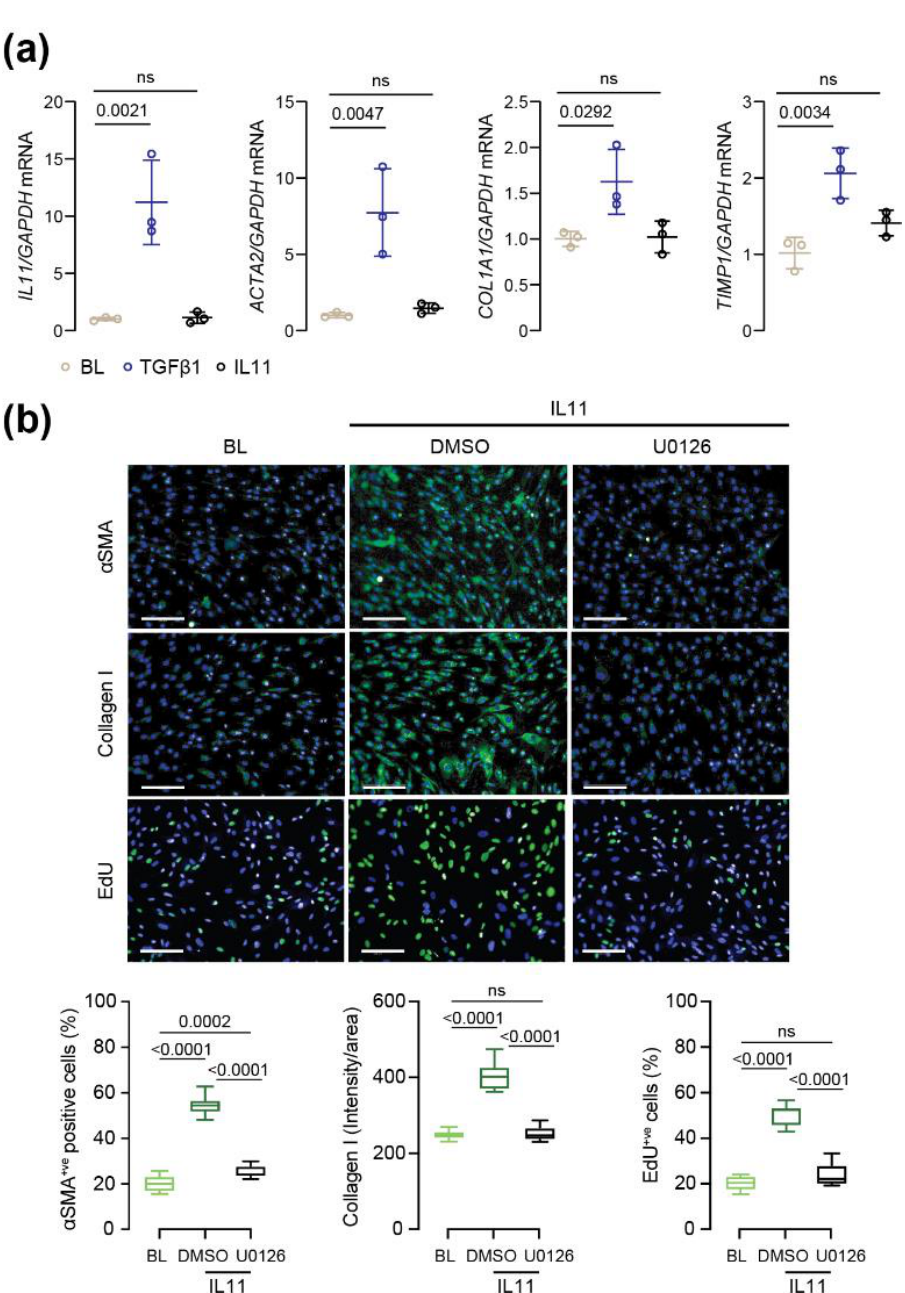
Figure 3. IL11 drives pancreatic stellate cell activation via ERK signalling and post-transcriptional effects. ( a ) RNA expression of IL11 , ACTA2 , COL1A1 and TIMP1 in PSCs treated with recombinant human TGF β 1 or IL11 (5 ng/mL; 24 h). ( b ) Representative immunofluorescence images and quan- tification of α SMA +ve cells, Collagen I intensity/area and EdU +ve cells at baseline and after 24 h treatment with IL11 (5 ng/mL) and ERK inhibitor U0126 (10 µ M). Data are represented as mean ± SD in panel ( a ) and as median and whiskers extending from minimum to maximum values in panel ( b ). Scale bars: 100 µ m. p values were determined by one way ANOVA (Dunnet’s correction) in ( a ) and one way ANOVA (Tukey’s correction) in ( b ). BL: baseline.